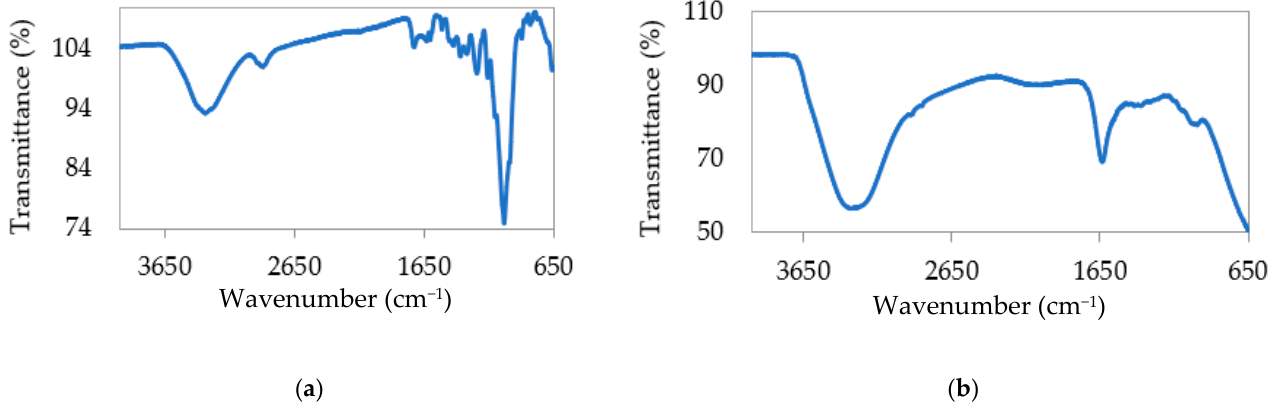
Figure 4. FT-IR graph for: ( a ) Raw bagasse and ( b ) extracted bagasse. Table 4. Bagasse functional groups based on FT-IR analysis.